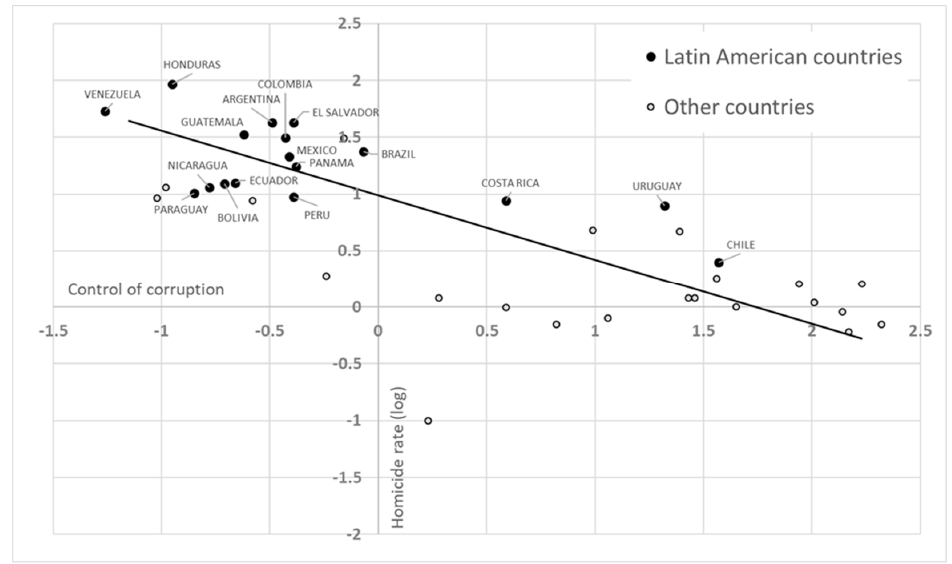
Figure 2. Control of corruption and homicide rates.